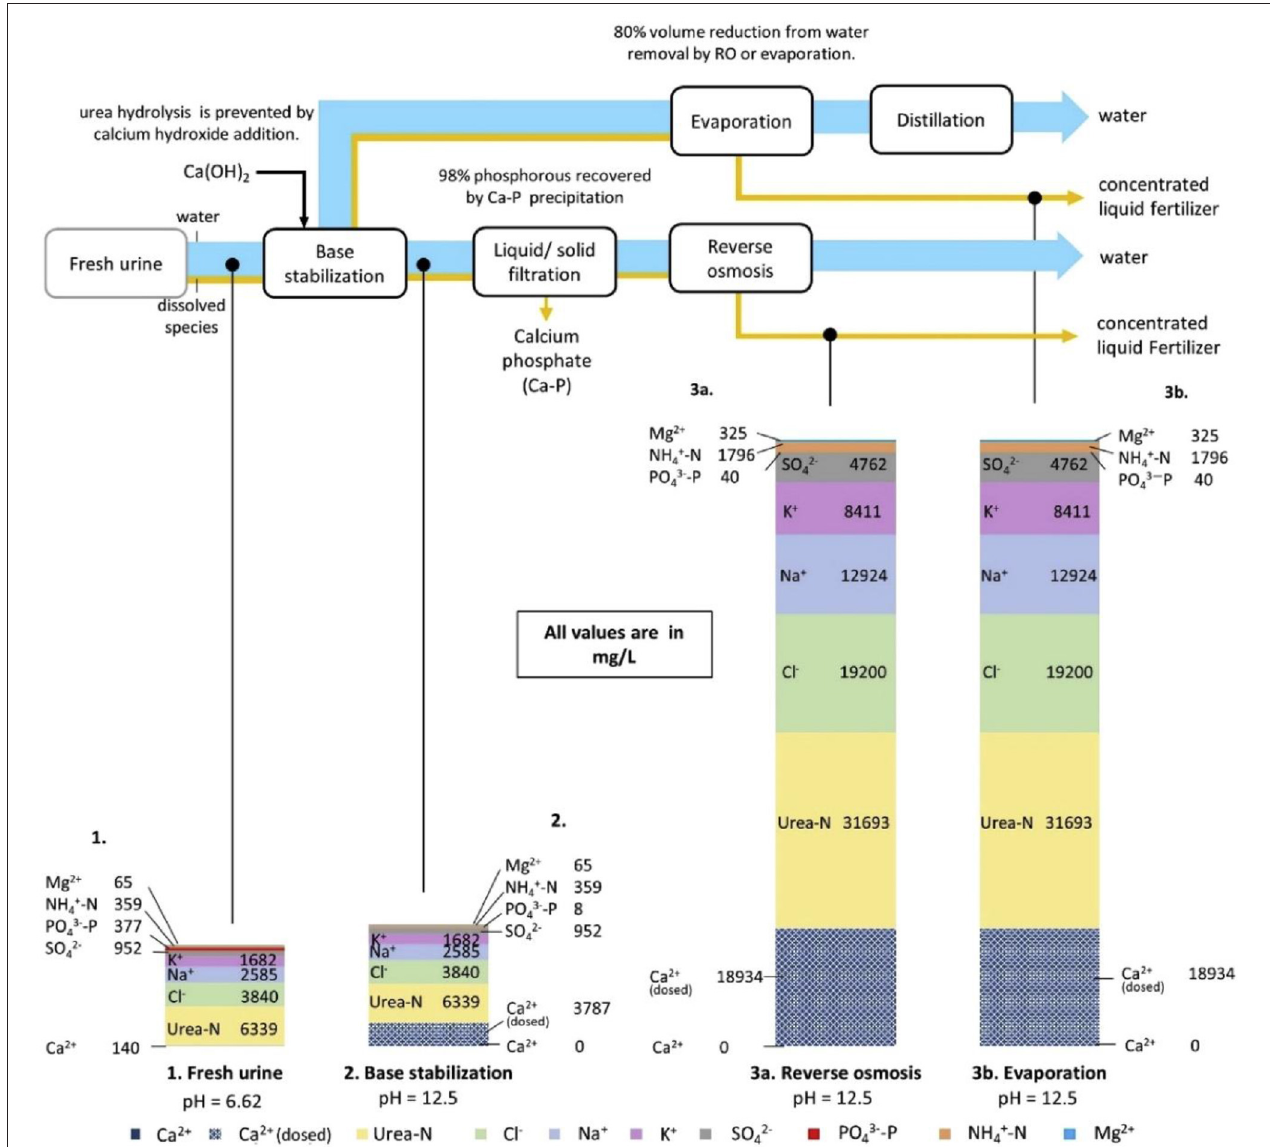
FIGURE 6 | The process of stabilizing urine with alkalization. The size of the arrows represents a mass flow of dissolved species in urine and water. Reprinted with permission from Chipako and Randall (2020). Copyright © 2019 Elsevier Ltd.